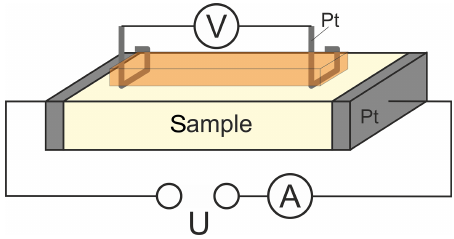
Figure 2. Schematic representation of the four-point contacting of the sample for AC and DC conductivity